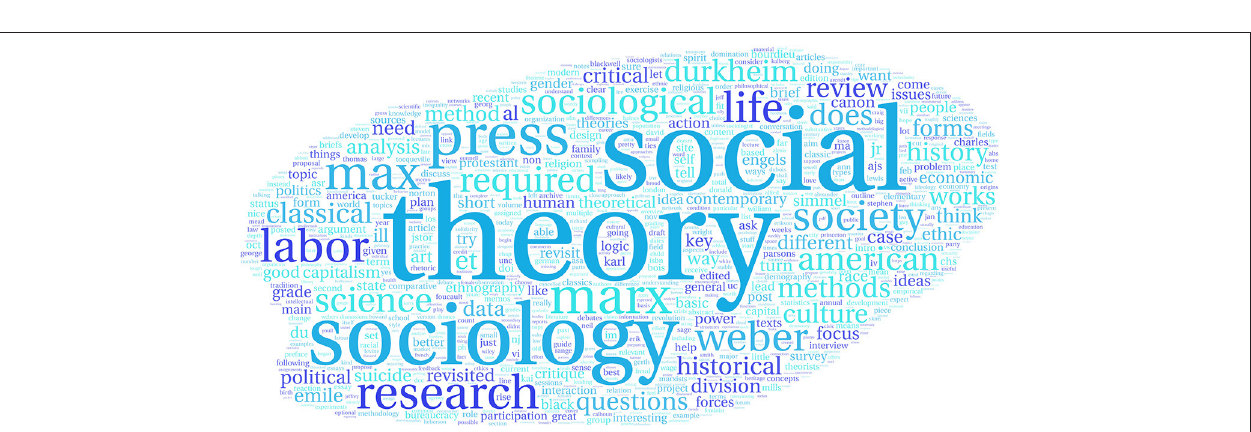
FIGURE 2 | A word cloud created from 9 syllabi and course descriptions of graudate introductory social theory / sociology courses from the top 12